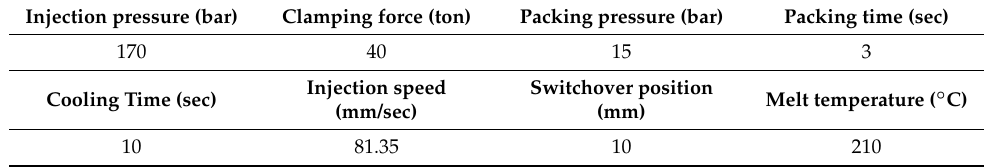
Table 8. The experimental parameters without the adaptive adjustment system.